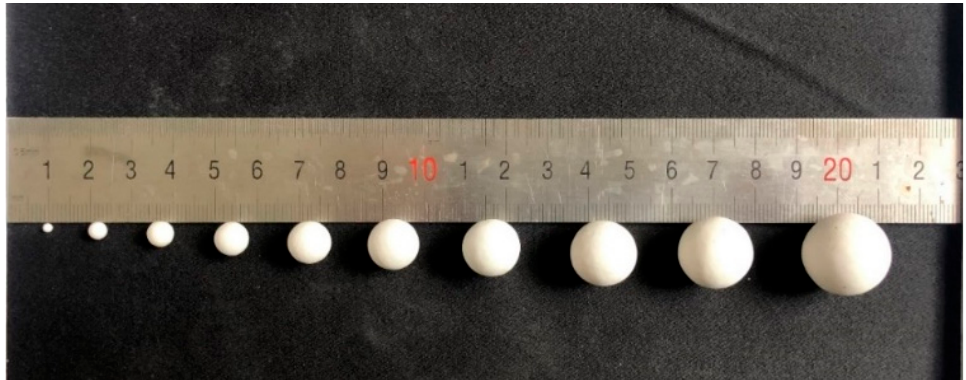
Figure 4. Diagram of 35% zirconia ceramic beads used in the